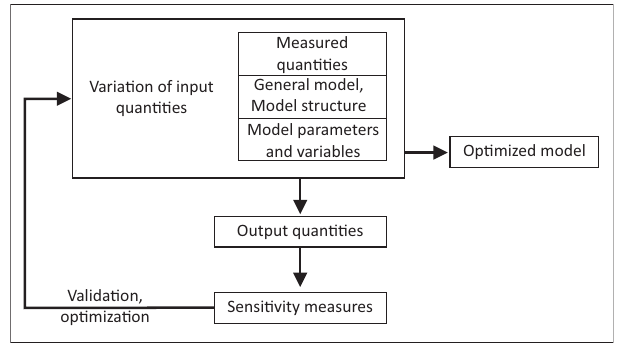
FIGURE 2: The general procedure for a sensitivity